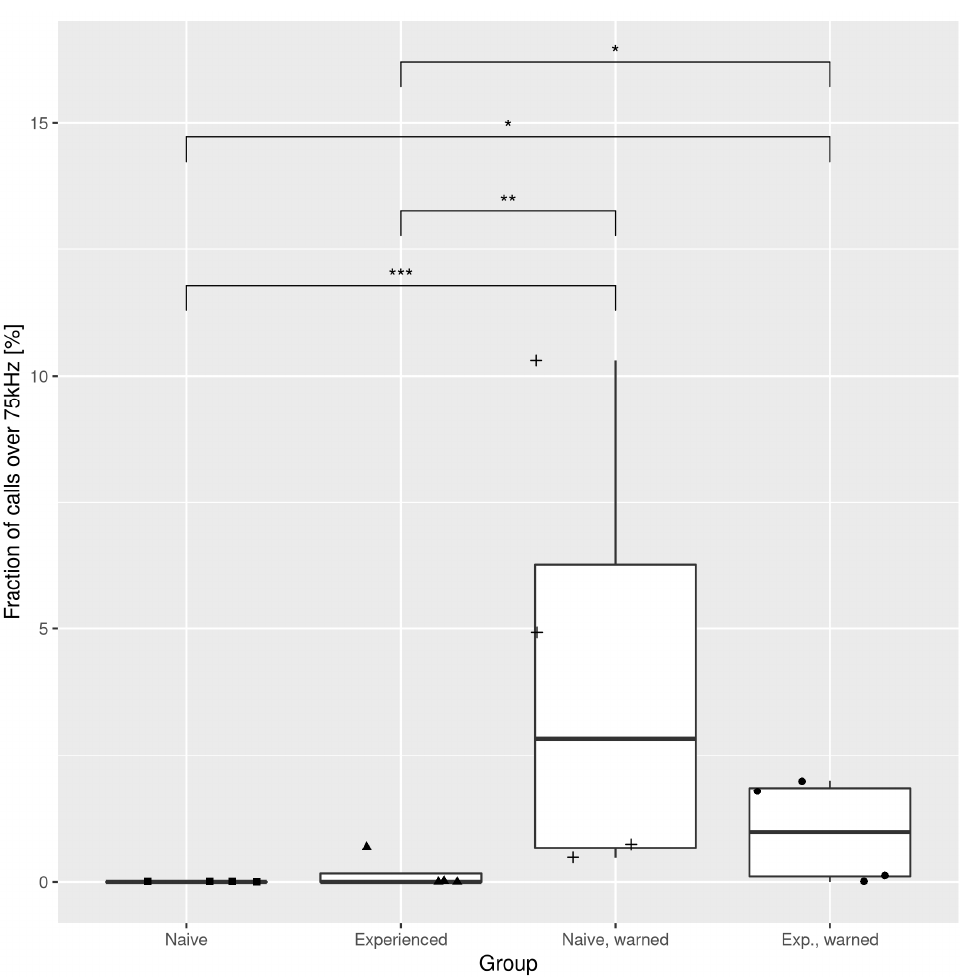
Figure 6. Fraction of 50 kHz calls with a frequency above 75 kHz in different experimental groups. Brackets mark significant differences identified by the Conover–Iman test. * p < 0.05; ** p < 0.01; *** p < 0.001.